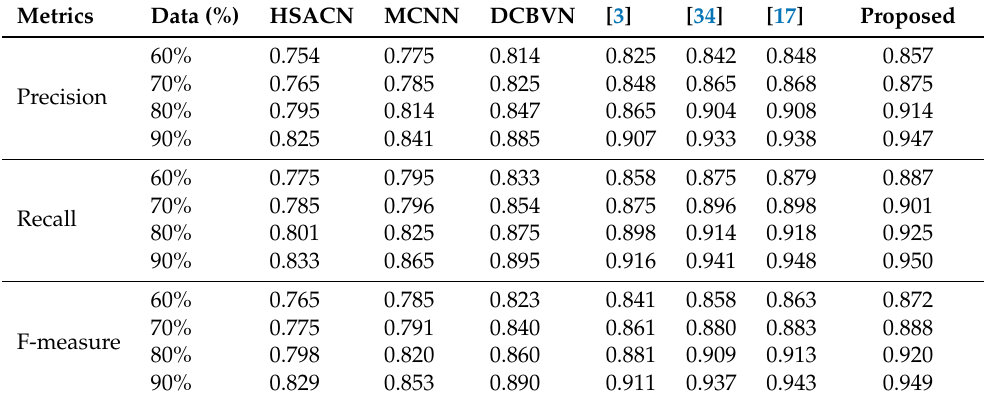
Table 2. Comparative analysis of Sentiment Classification for Yelp 2013 dataset in terms of precision, recall and